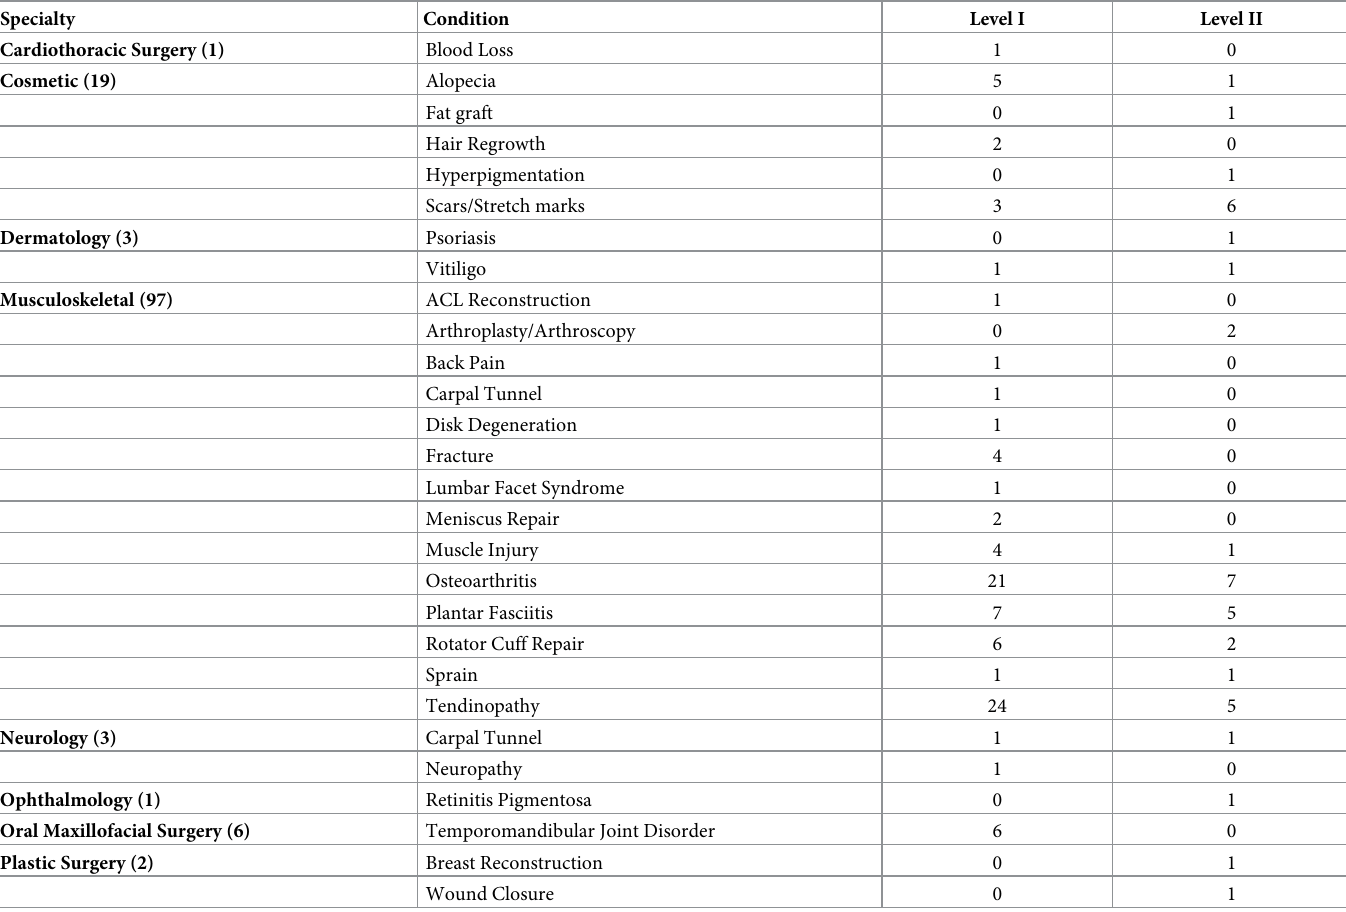
Table 1. Number of Level I and Level II studies investigating platelet-rich plasma treatment organized by medical specialty.